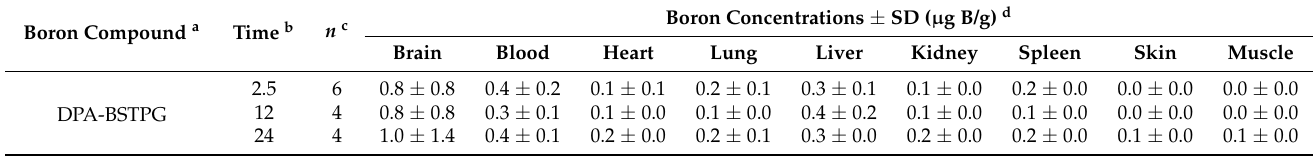
Figure A1. The chemical structure of DPA-BSTPG. Table A1. Summary of the boron concentrations of systemic organs after administration of DPA- BSTPG on the F98 rat glioma model.